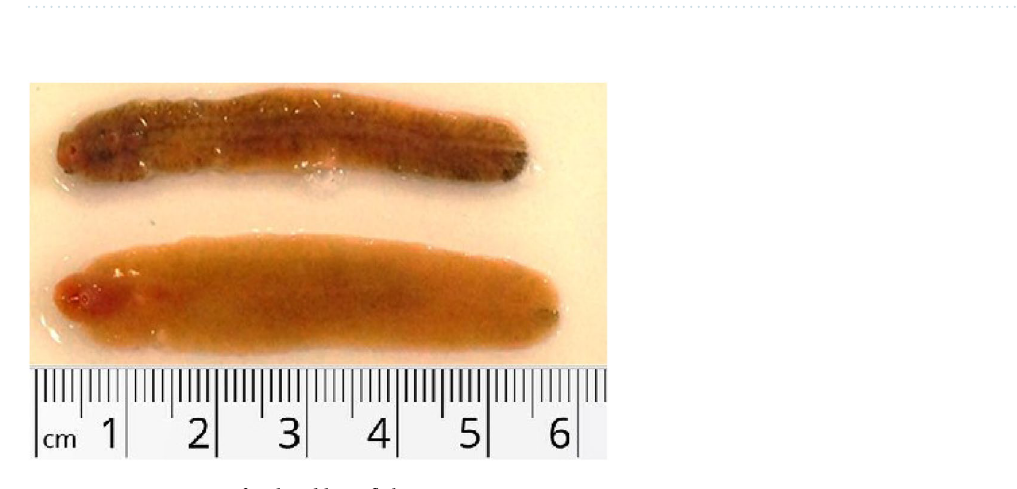
Figure 1. Dimension of isolated liver